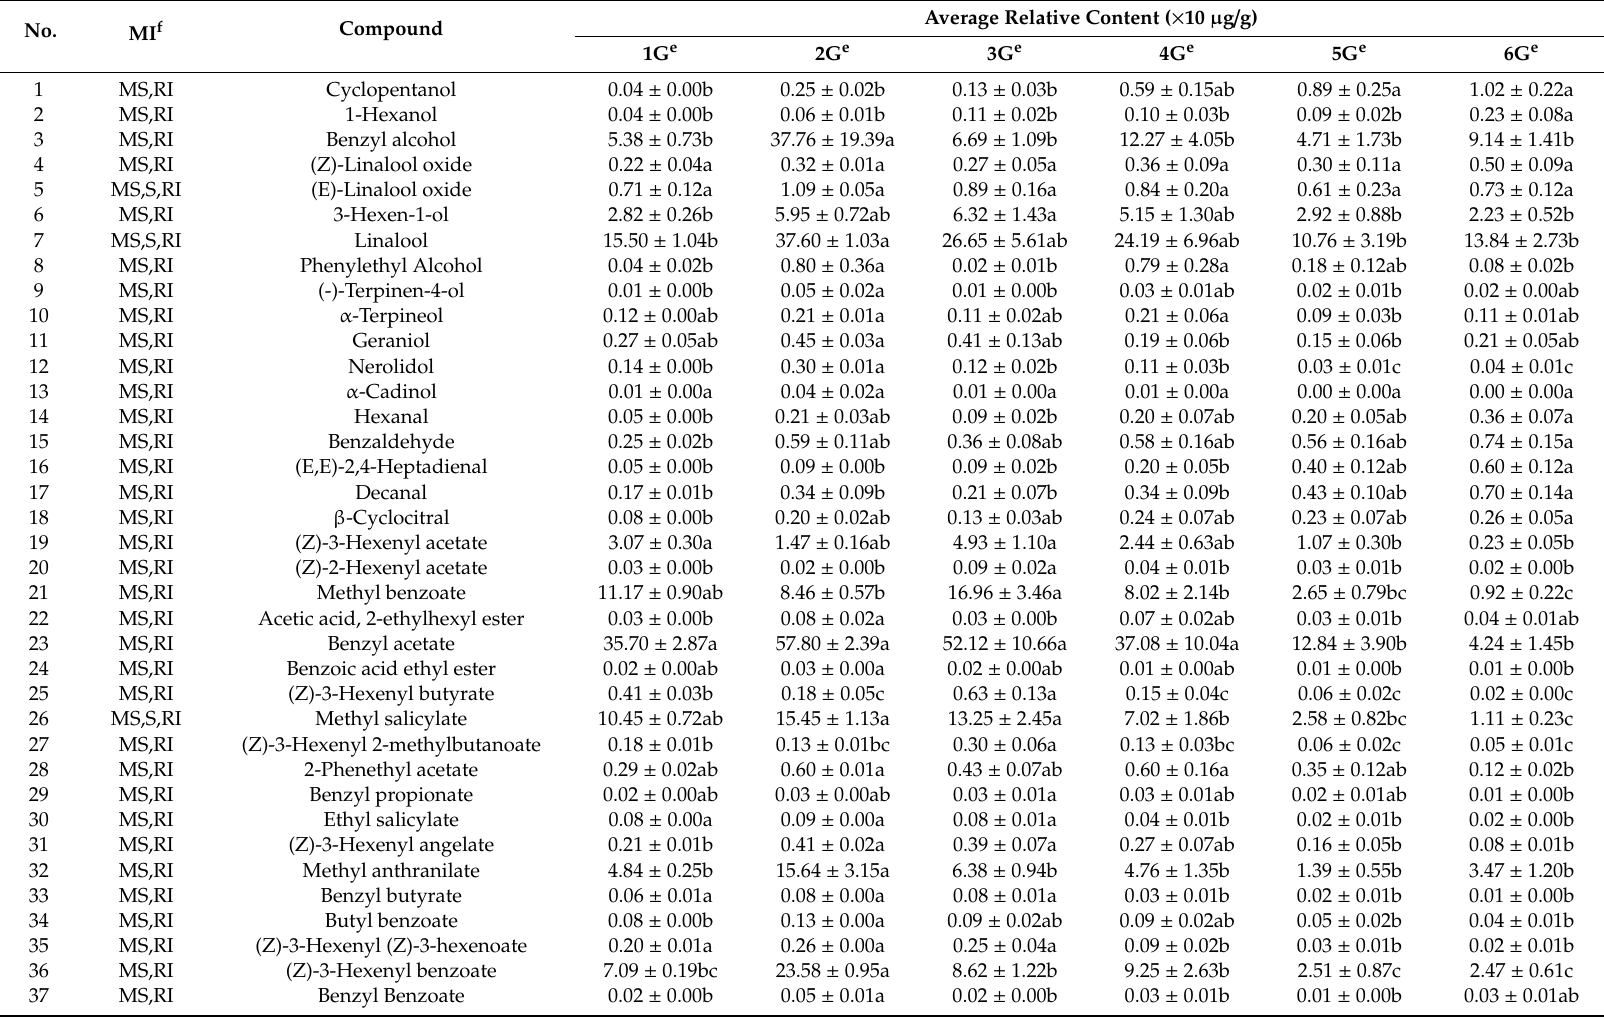
Table 2. VOC of grade jasmine